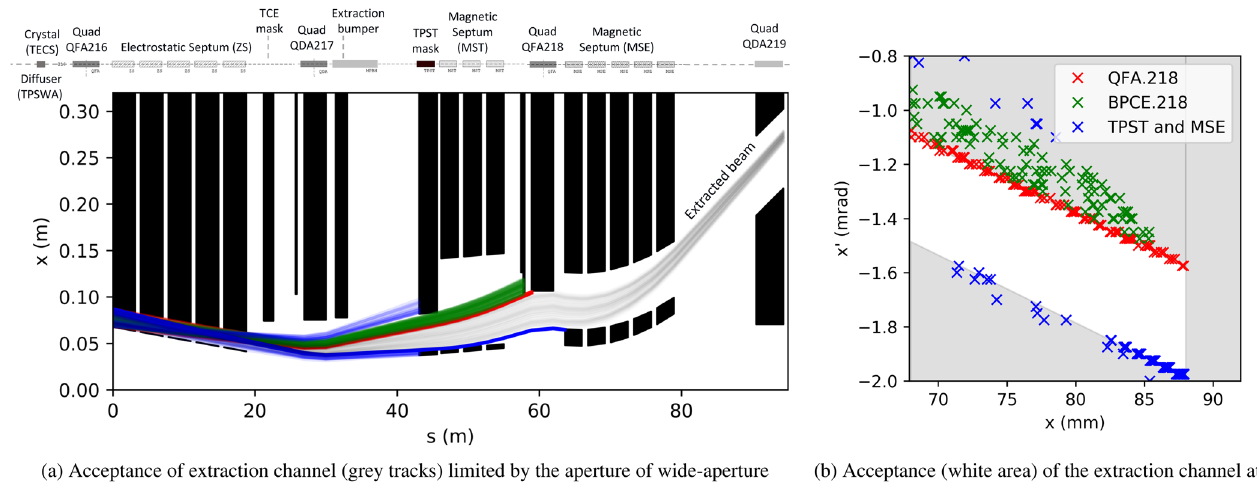
FIG. 1. Layout of the LSS2 extraction straight and the phase space acceptance of the extraction channel at the entrance to the electrostatic septum (ZS). The phase space acceptance is delimited along with selected particle tracks lost on relevant apertures. The ¼ 68 blade of the ZS cuts the circulating beam at an amplitude x ZS